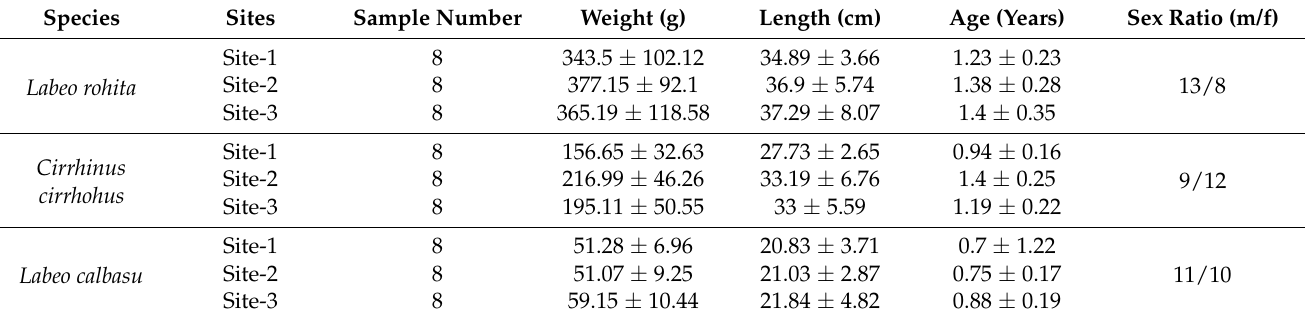
Figure 1. Map showing three sampling stations in Hakaluki haor . Table 1. Morphometric characteristics of the collected fish samples clarified by species and area (Values are presented as mean ±